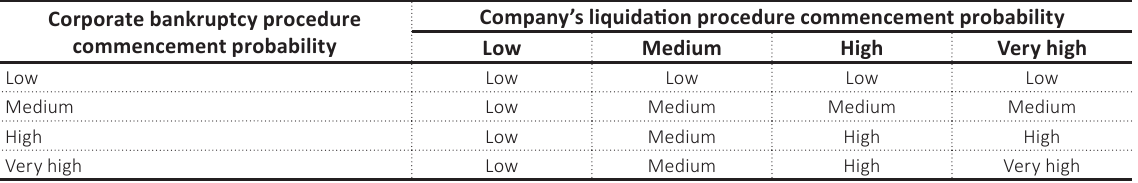
Table 2. Matrix of the pairwise comparison of the qualitative assessment results for the